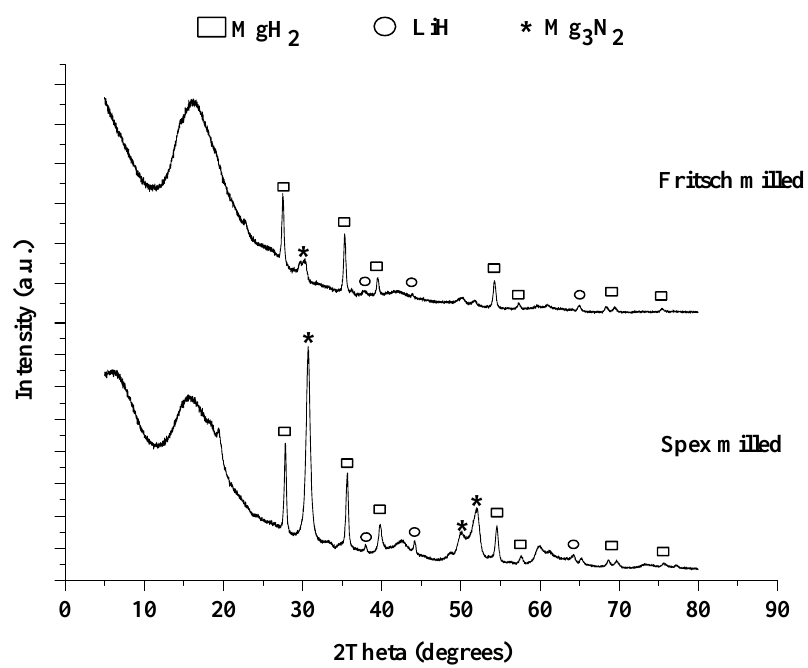
Figure 8. XRD pattern of Spex (bottom) and Fritsch (top) milled 1:1 LiNH the 4th hydrogenation.